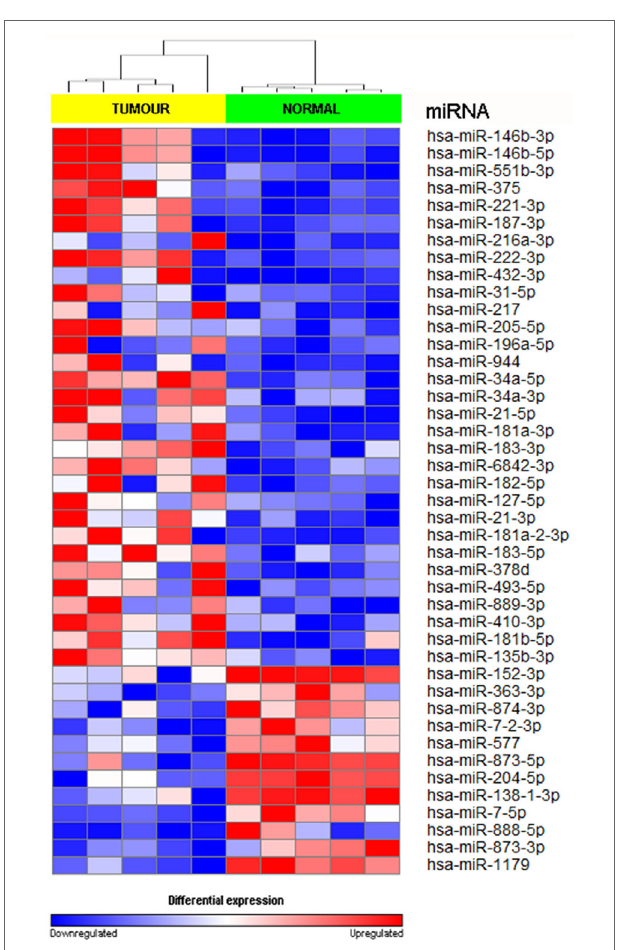
FigUre 2 | Hierarchical clustering and heatmap for microRNA (miRNA) expression profile in papillary thyroid carcinoma LNN versus adjacent normal comparison group. The list of miRNA were filtered with p value < 0.05 and log2-fold change ≤− 1.0 or ≥ 1.0. A total of 43 miRNA have significant differentially expression. The sample labeled in yellow bar represents tumor sample while green bar represents normal samples. Color key illustrate the relative expression of miRNA in all samples. Red indicates high expression level while blue indicate low expression level. Dendrogram showed that all samples were clustered well according to their respective groups.